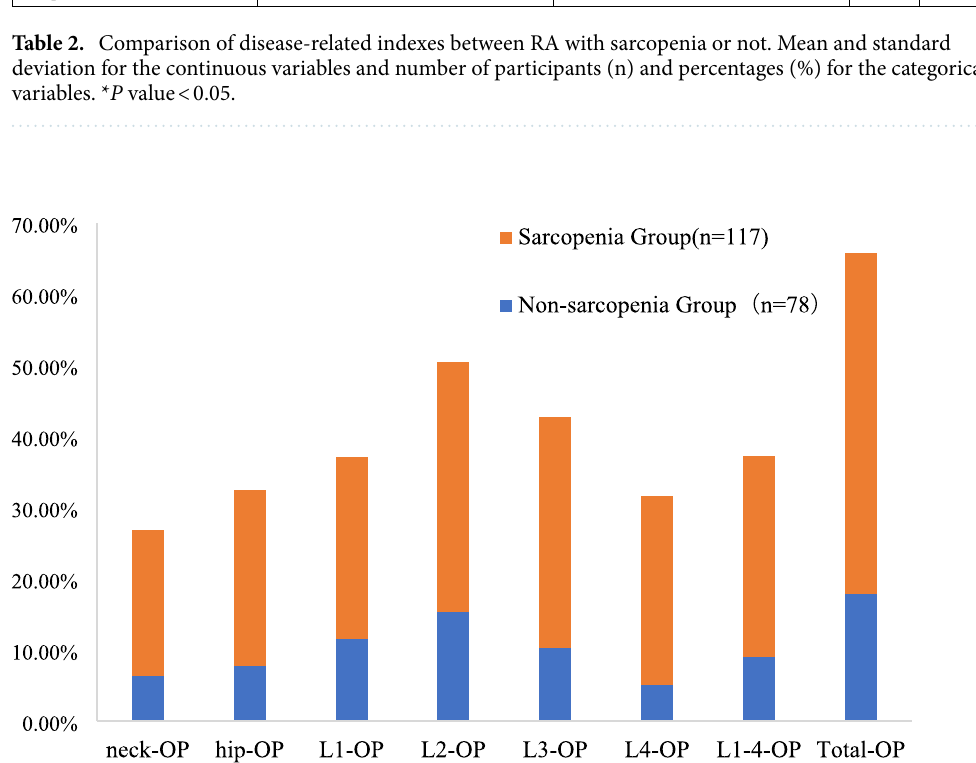
disease duration in female RA patients with sarcopenia was 8 (3–15) years, significantly higher than that in female RA without sarcopenia (5 (1–15) years, z = 2.013, P < 0.05). Sarcopenia group had statistically significant higher incidence of GCs usage (64.1%) compared to non-sarcopenia patients (44.9%, x 2 = 7.039, P = 0.008). The average of BMI in female RA patients with sarcopenia was (21.00 ± 3.34), which was significantly lower than that in female RA without sarcopenia (24.36 ± 3.53, t = 6.062, P < 0.001) (Table 2). The percentage of neck/Hip/L1/ L2/L3/L4/L1-4/total-OP in female RA with sarcopenia was significantly higher than that in female RA without sarcopenia ( x 2 = 15.277, 23.443, 15.720, 15.142, 24.889, 20.067, 19.114, 18.200, P < 0.001) (Fig. 3). Comparison of disease activity, joint function and joint structural damage between different groups. Compared with RA without sarcopenia, ESR and CRP in female RA with sarcopenia were higher, and the differences were statistically significant ( P < 0.05–0.001), suggesting higher disease activity (Table 2). The differences in the com-